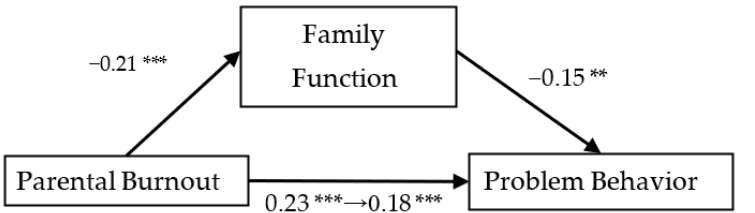
Figure 2. The mediating effect of family function on parental burnout and problem behavior. ** p < 0.01, *** p < 0.001.